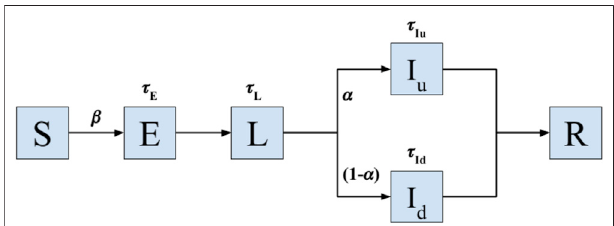
FIGURE 4 | Model of Covid-19 transmission. Transition model used to simulate the spread of infectious disease with epidemiological characteristics of Covid-19 on a real sequence of contact data in a geriatric unit. Upon close contact with a latent (L) or infected case (I u and I d stand for infected asymptomatic and diseased states, respectively), an individual in susceptible state (S) will transition to the state of exposed (E) with probability β , which controlsthetransmissibilityofthedisease.TheindividualsintheEstateremain in such a state for a time interval τ E before entering into the latent state (L). After aduration τ L an individual inthe latent state will transitionwithprobability α toaninfectedundetected(orasymptomatic)state(I u ),andwithprobability1- α to an infected diseased (I d ) state. Each infected individual remains in its infected state for latencies τ I u and τ I d , respectively, before being effectively removedfromthespreadingpopulationafterbecomingremovedorrecovered (R). The model operates until all individuals belong to either the S or R states, the moment in which the local outbreak ends. All latencies are probabilistically sampled from Gamma distributions fi tted for the dynamics of Covid-19 (Lauer et al.,